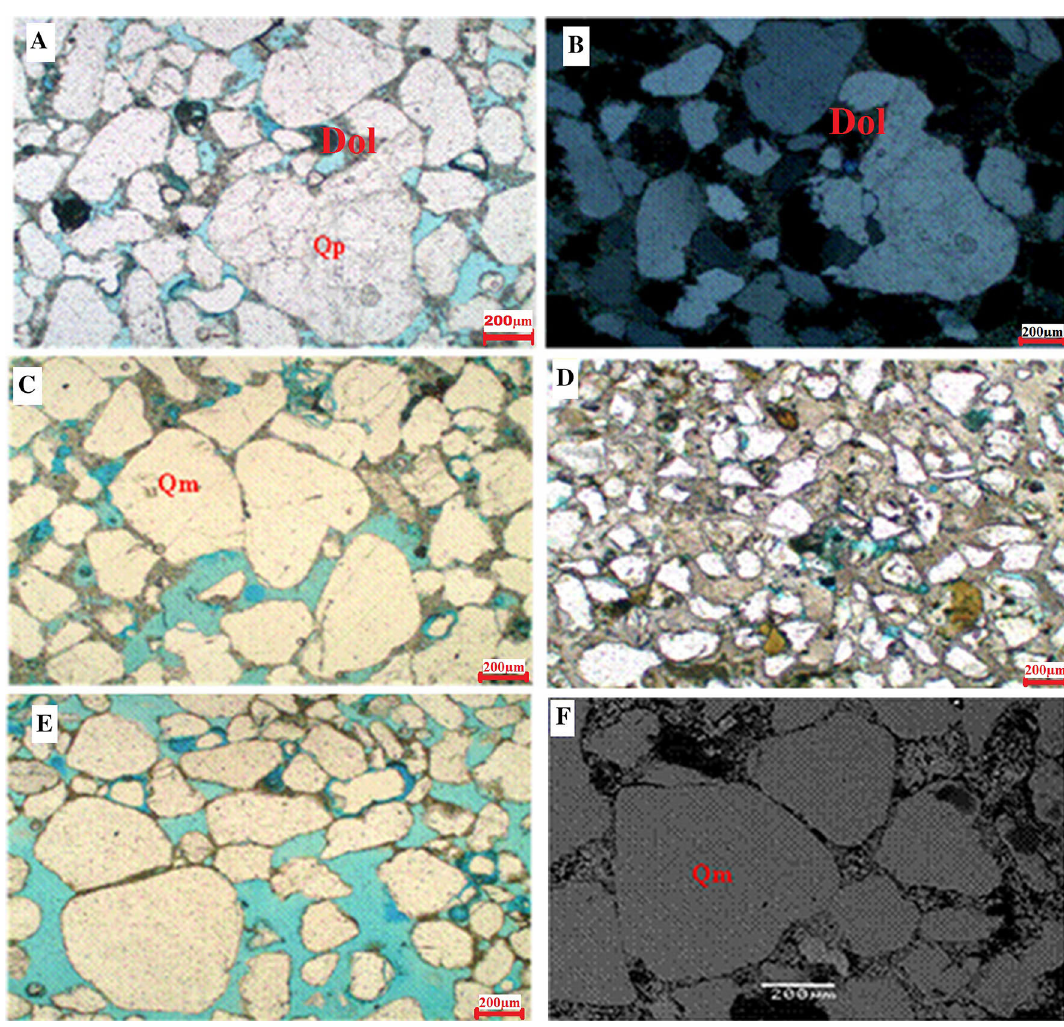
Fig. 5 a – e photomicrographs show siliciclastic–disseminated dolo- mite; a , b quartz arenite with sutured polycrystalline grains (PQ), highly porous, and slightly cemented with dolomite c , showing concave-convex and straight quartz grain contacts, d showing arenite